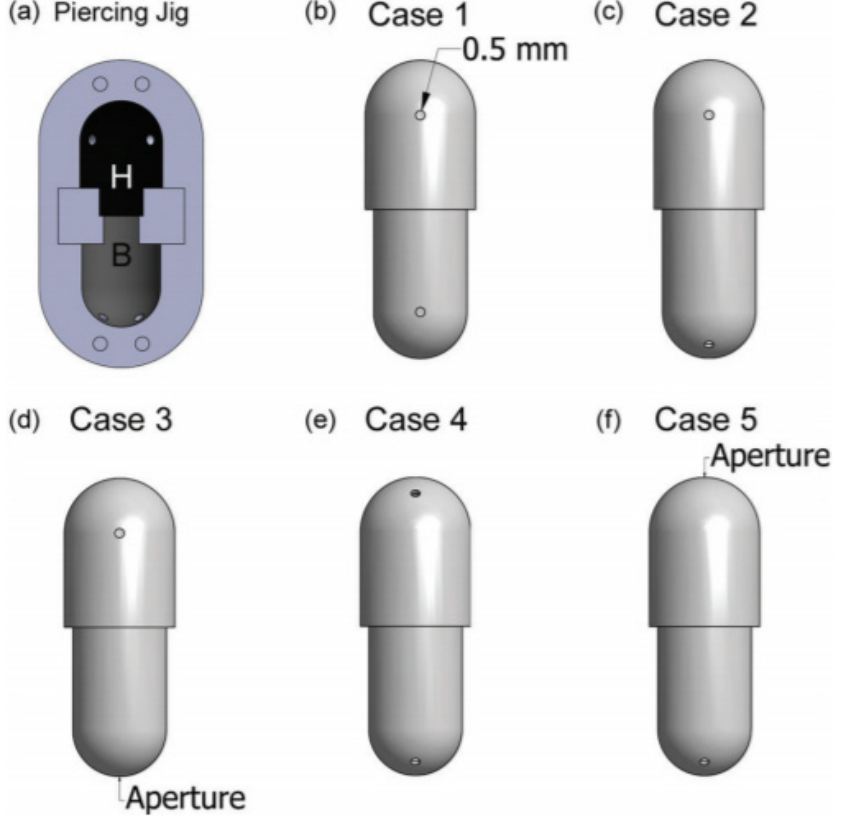
Figure 4. Five different cases of capsule aperture orientations generated by capsule jig piercing at different orientations. Reproduced with permission from [78], Elsevier, 2014.